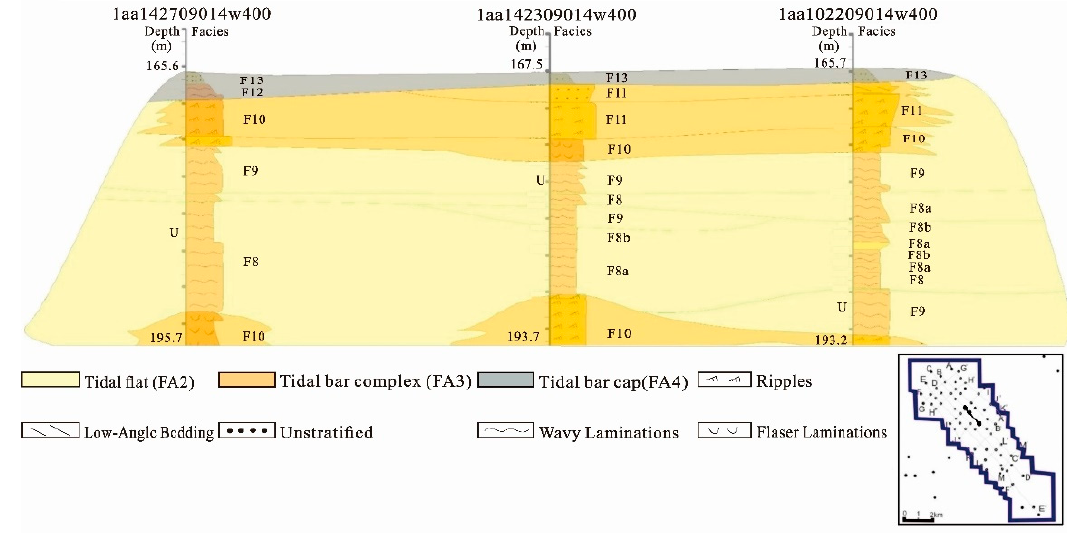
Figure 7. Facies and facies associations of tidal bar complex, tidal flat and tidal bar cap.